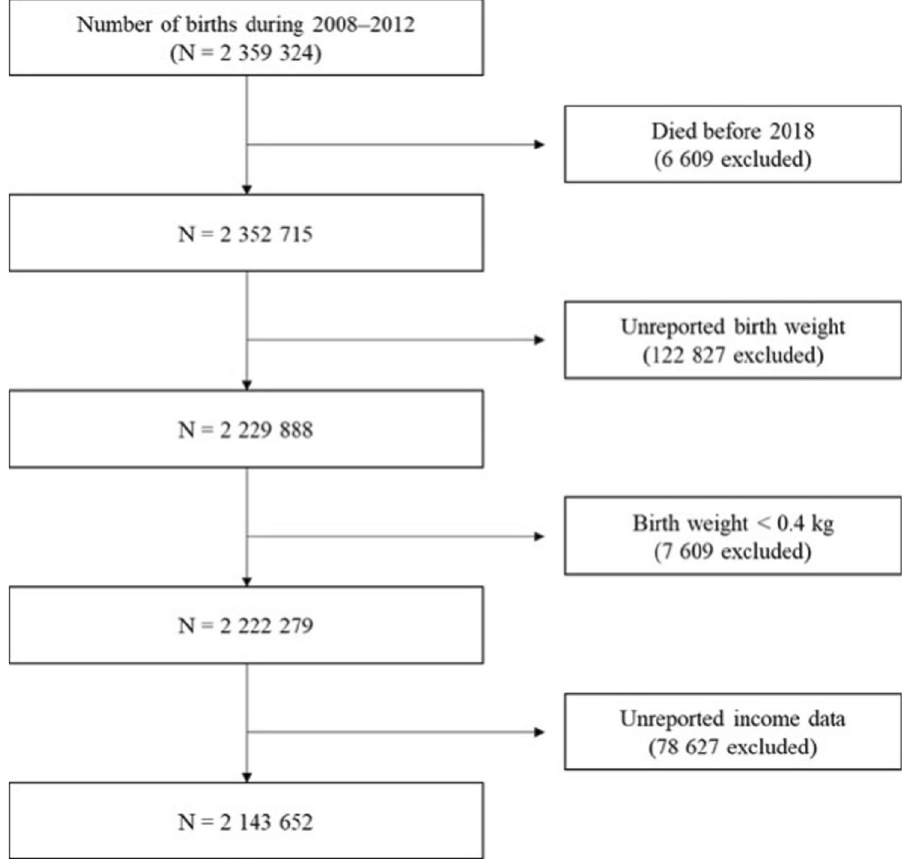
Figure 1. Flow chart of study participant